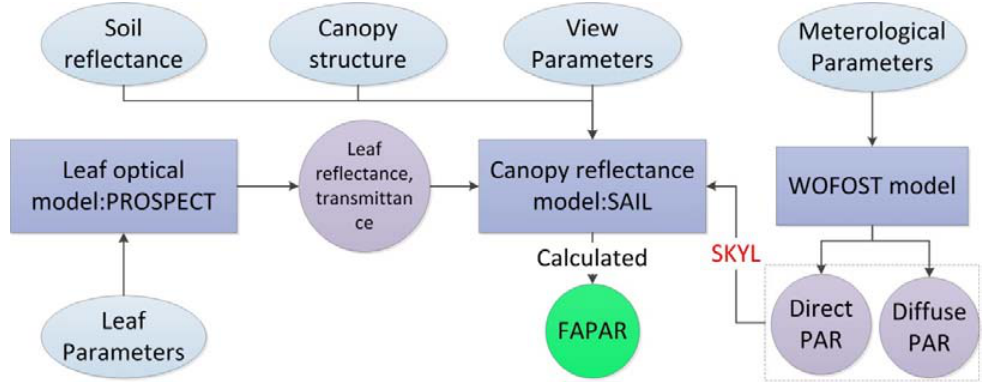
Figure 3. A flowchart of the coupled growth-canopy model for describing the process of the FAPARsimulation; PROSPECT is the Leaf Optical Properties Spectra model, SAIL is the Scattering by Arbitrarily Inclined Leaves Model, WOFOST is world food study model, PAR is the photosynthetically active radiation, and FAPAR is the fraction of absorbed photosynthetically active radiation.